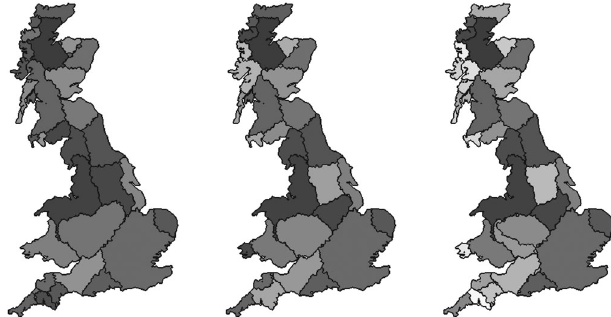
FIG. 9. Results of k -medoids cluster analysis of 20 synthetic binary linguistic variables when σ ¼ 10 km and β ¼ 1 . 1 at t ¼ 150 . Edit distance [9] used as distance metric. k values from left to right are k ¼ 16 , 22, 30.